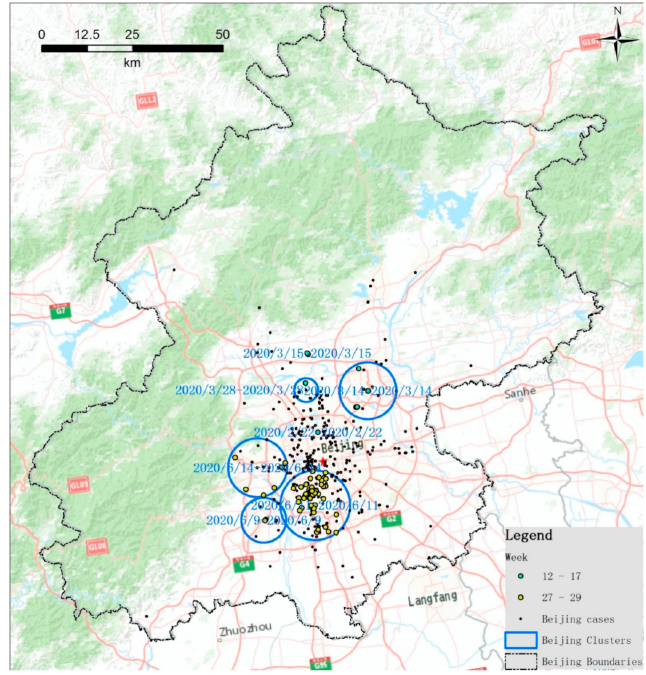
Figure 6. Zoomed space-time clusters of COVID-19 at the family-level with a maximum spatial scanning window size of 10 km in Beijing city from 2 December 2019 to 20 June